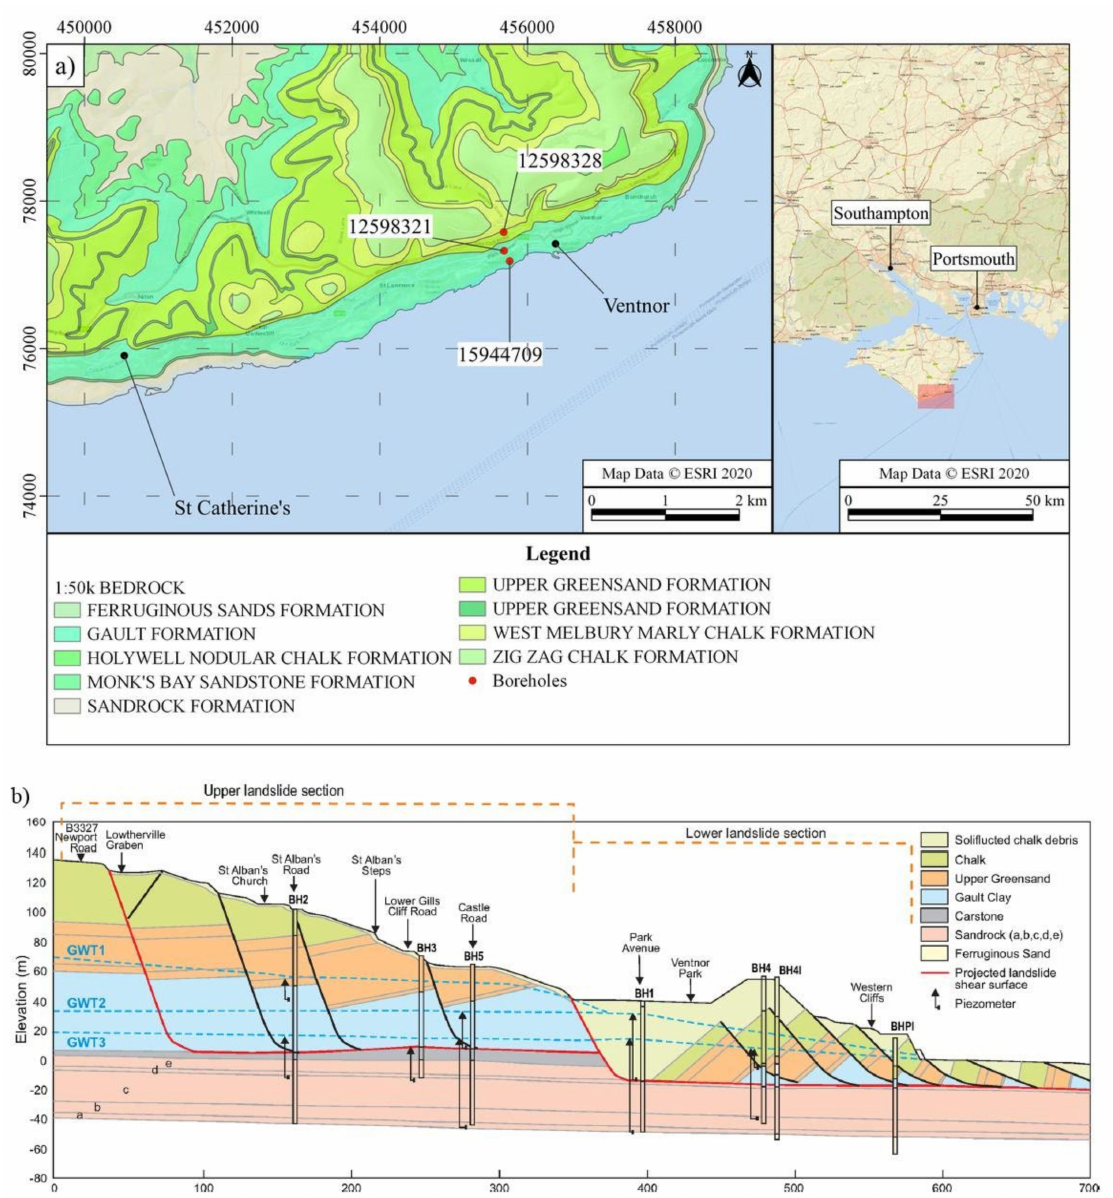
Figure 2. Study area map with BGS 1:50,000 bedrock geology map overlain, with 3 borehole records obtained from the BGS online portal indicated in red with reference number also given [25] ( a ). Ground model developed by Halcrow [26] approximately in line with 3 boreholes in ( a ) showing postulated failure surfaces ( b ). Upper landslide section extends from Newport Road to approximately Park Avenue. Lower section extends from north of Park Avenue beyond the Western Cliffs and into the sea bed. The bedrock geology map of Isle of Wight was accessed via the EDINA DigiMap service, using data provided by BGS last updated in 2013, plotted on QGIS with background imagery from the ESRI World Street Map (Service Layer Credits: Esri, DeLorme, HERE, USGS, Intermap, iPC, NRCAN, Esri Japan, METI, Esri China (Hong Kong), Esri (Thailand), MapmyIndia,